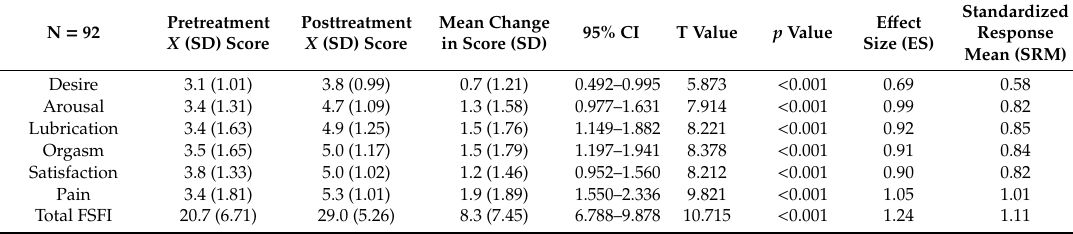
Table 8. FSFI Mean change in scores, and